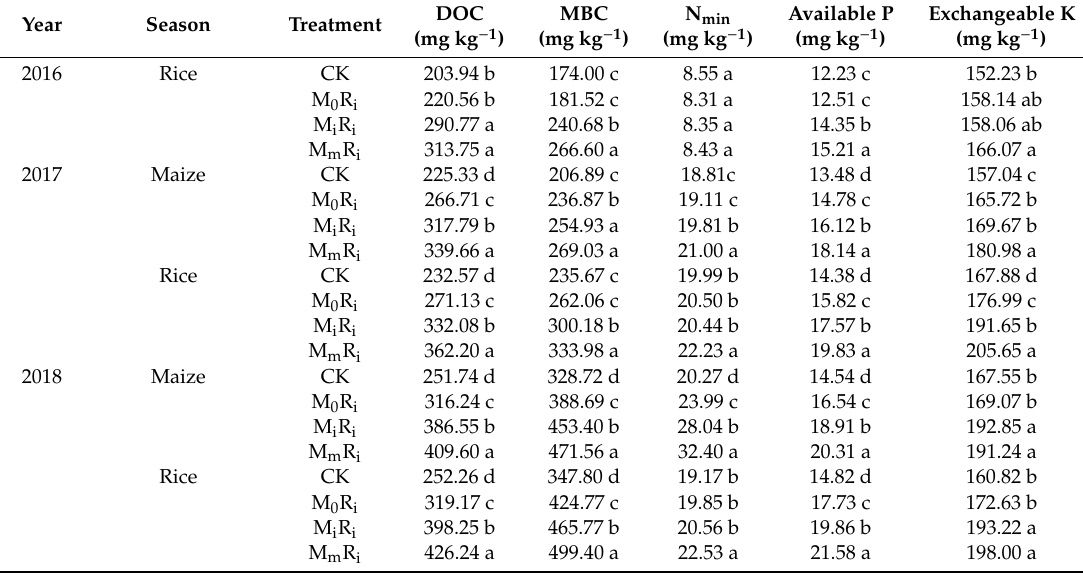
Table 3. Changes in DOC, MBC, N min , available P, and exchangeable K content in the 0–20 cm soil layer under di ff erent straw incorporation